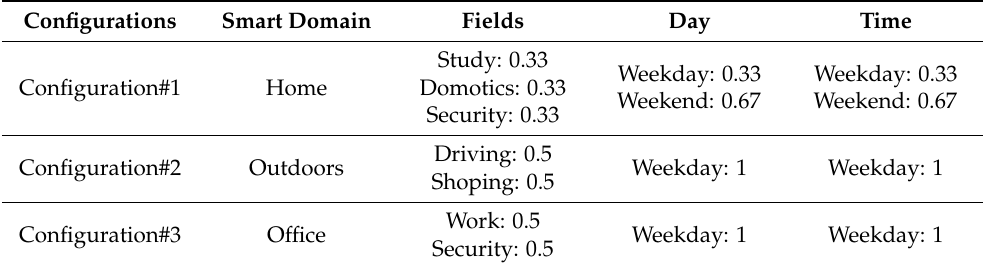
Table 5. Explicit weights for three profiles